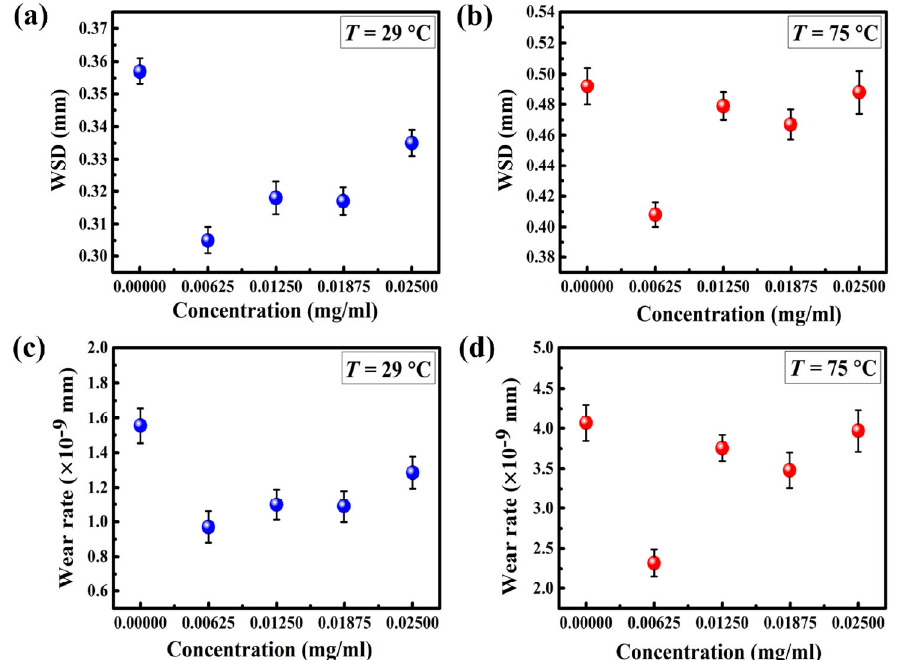
Fig. 7 WSD plot with varying concentration of nano-oil at (a) 29 °C and (b) 75 °C. Wear rate plot with varying concentration of nano-oil at (c) 29 °C and (d) 75